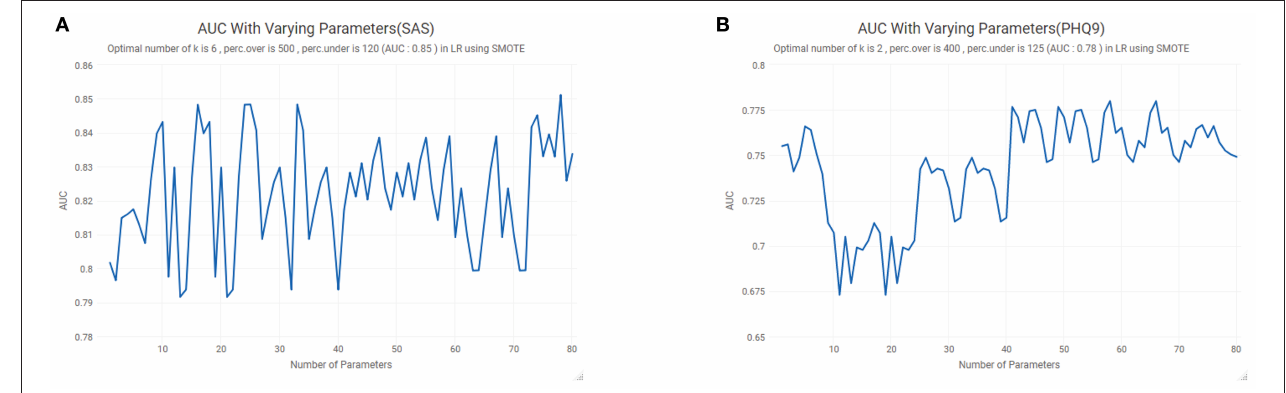
FIGURE 1 | The Synthetic Minority Oversampling Technique (SMOTE): (A) anxiety; (B) depression. AUC, area under the